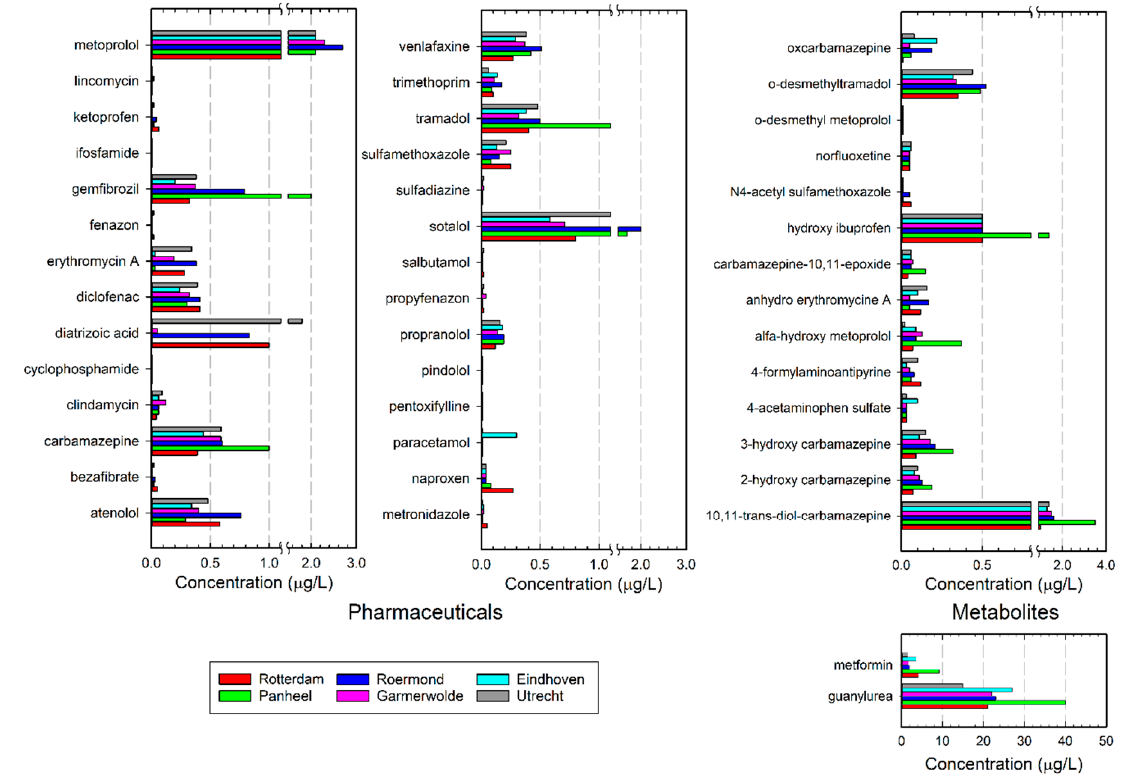
Figure 2. Concentrations of pharmaceuticals (left two graphs) and metabolites (right graph) in WWTP effluents in The Netherlands. The concentrations of metformin and its metabolite guanylurea are present in significantly higher concentrations, and therefore shown separately in the lower right graph.